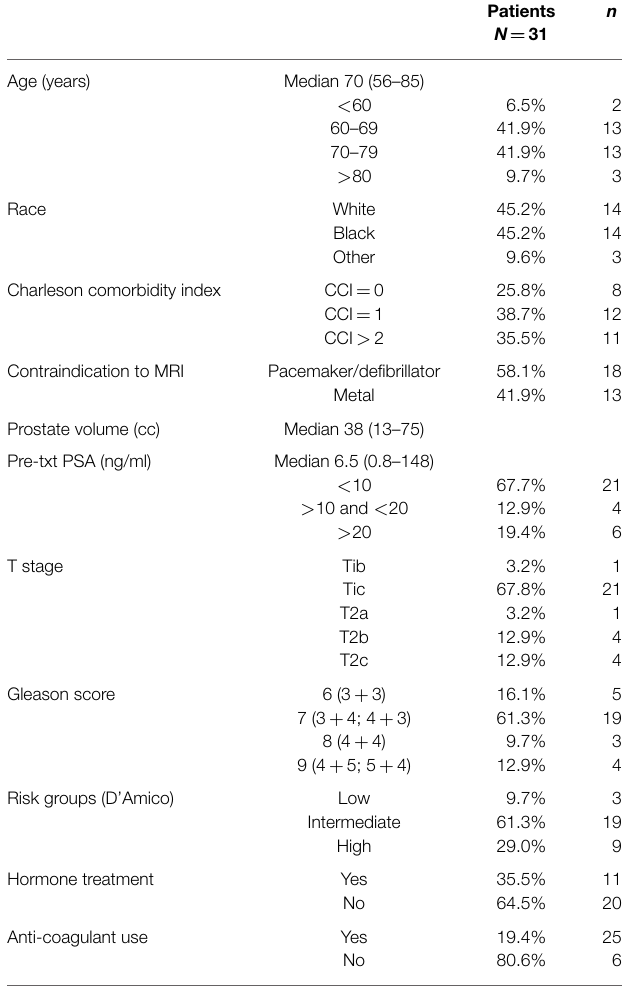
TABLE 1 | Baseline patient characteristics and treatment .